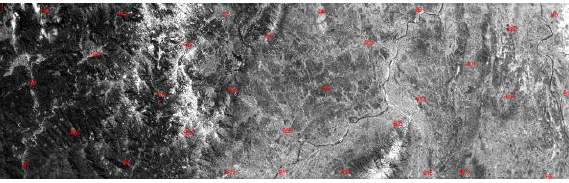
Figure 4. Distribution of selected control